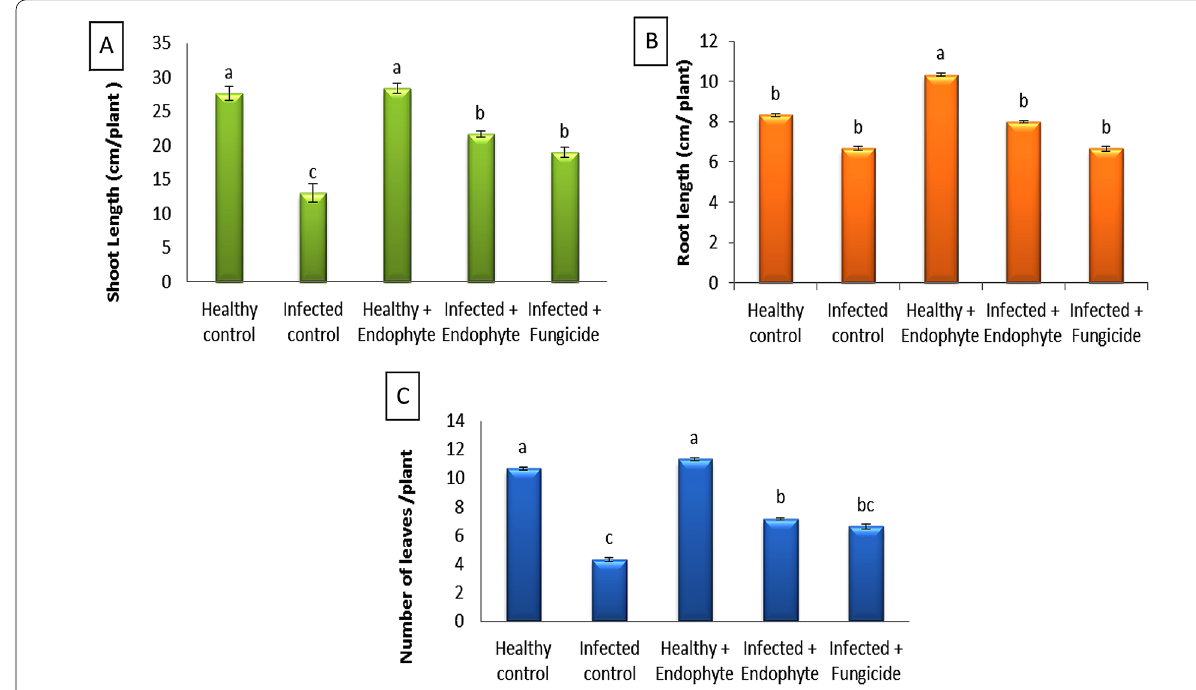
Fig. 3 Effect of A . terreus on A shoot length, B root length and C number of leaves of S. melongena . Each bar represents mean